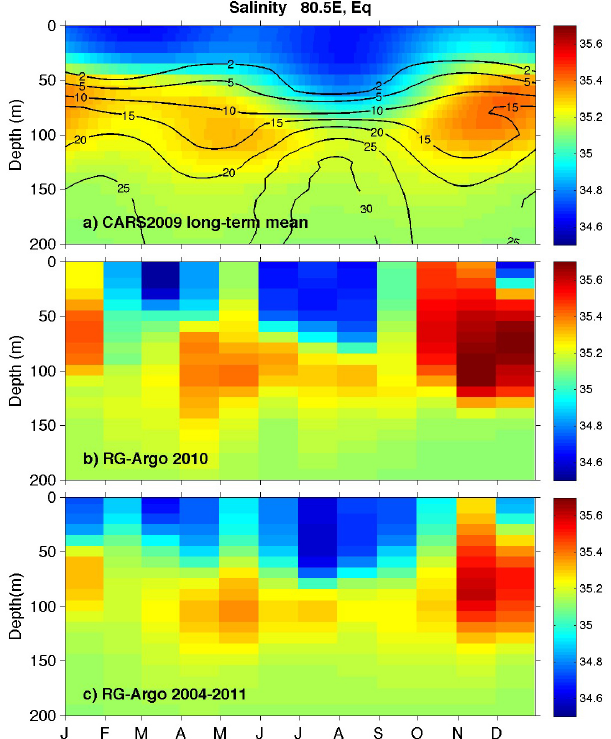
Figure 7. Time–depth sections of salinity (PSS-78) for the mooring location. (a) The long-term mean from CARS with nitrate (mmol m − 3 ), also from CARS contoured; (b) the RG-Argo product for 2010; (c) the RG-Argo climatology based on data from 2004 to